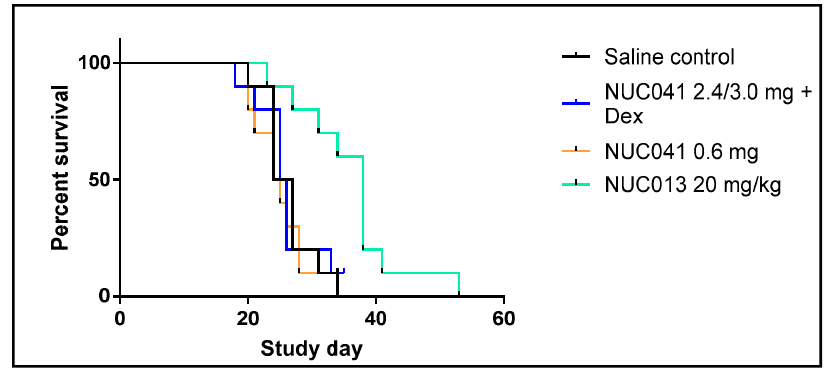
Figure 5. Survival proportions of NUC013, NUC041 with dexamethasone (Dex) pretreatment, and NUC041 vs. SC ( n = 10 per group) in mice with human NSCLC NCI-H460 tumor implants. Survival refers to animals that were not removed from the study by death or per protocol euthanasia. Mice were administered the following doses and regimens: NUC013 20 mg/kg IV qd for three consecutive